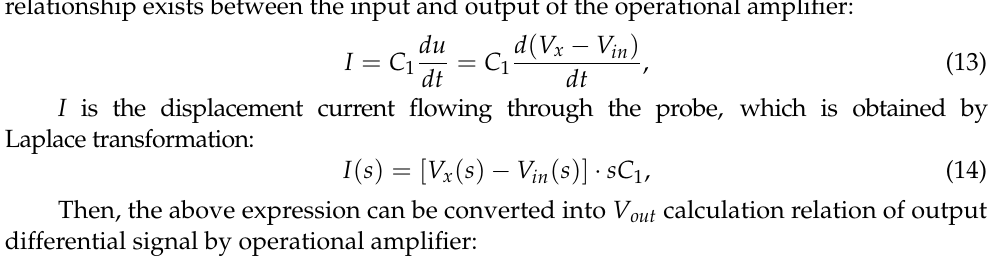
Figure 9. Schematic diagram of conditioning circuit.